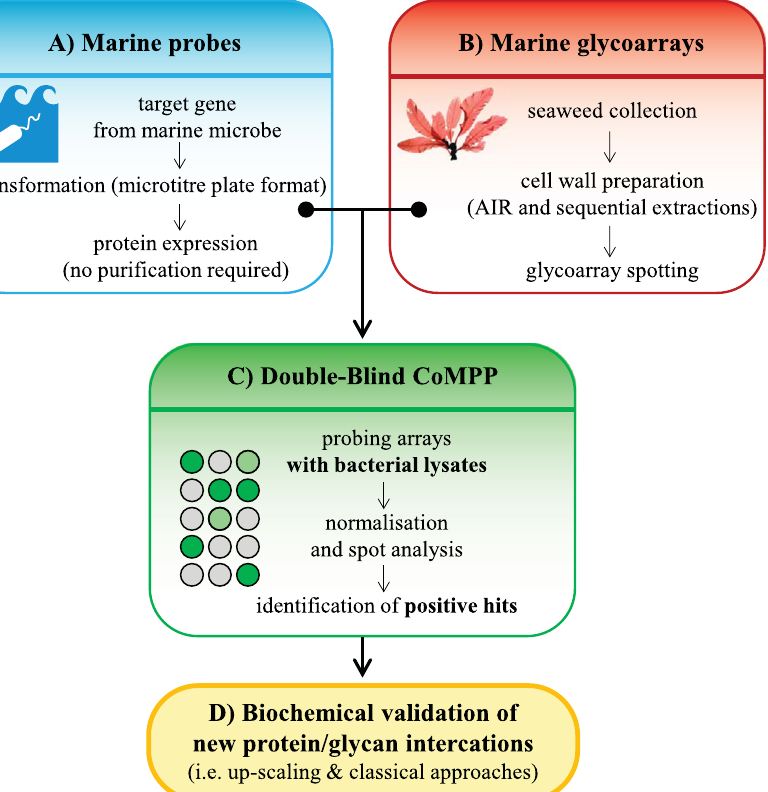
Figure 1. Schematic of the DB-CoMPP technique. An example using marine samples is shown. ( A ) Genes encoding carbohydrate-binding proteins with unknown specificities are selected and the corresponding recombinant proteins are expressed in a medium throughput manner. ( B ) Cell wall polymers are sequentially extracted using dedicated protocols. They are printed onto the array following the standard CoMPP technique. ( C ) The arrays are probed with the supernatants of bacterial lysates. Signals from negative controls are used to subtract background. The samples giving positive signals are identified. ( D ) The purified probes and their corresponding ligands are gathered in larger amounts and used for biochemical validation of protein-glycan